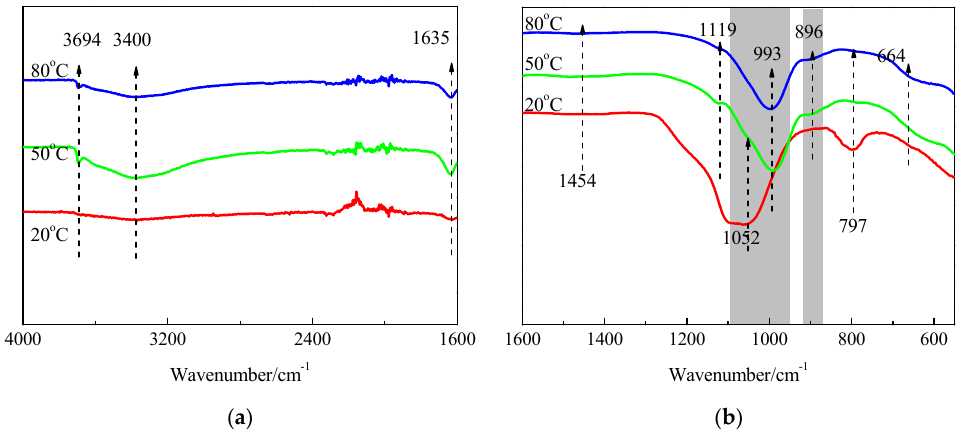
Figure 15. FTIR spectra of MgO-SF pastes prepared using MgO calcined at 1450 °C for 2 h after 7 d: